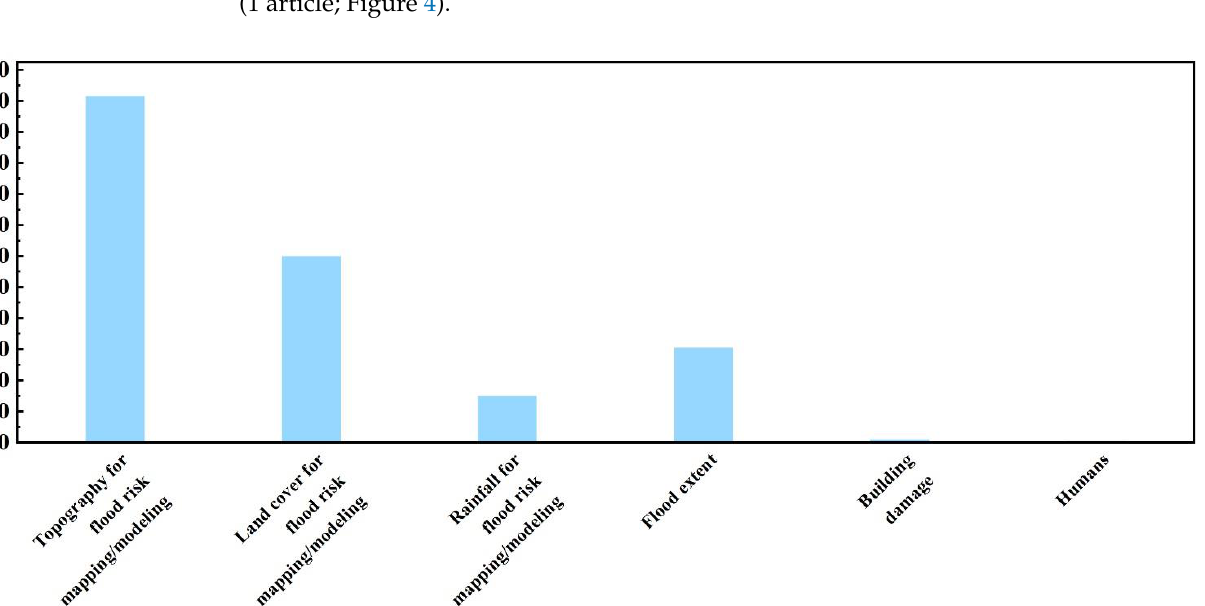
Table 3. Disaster management function and activity.